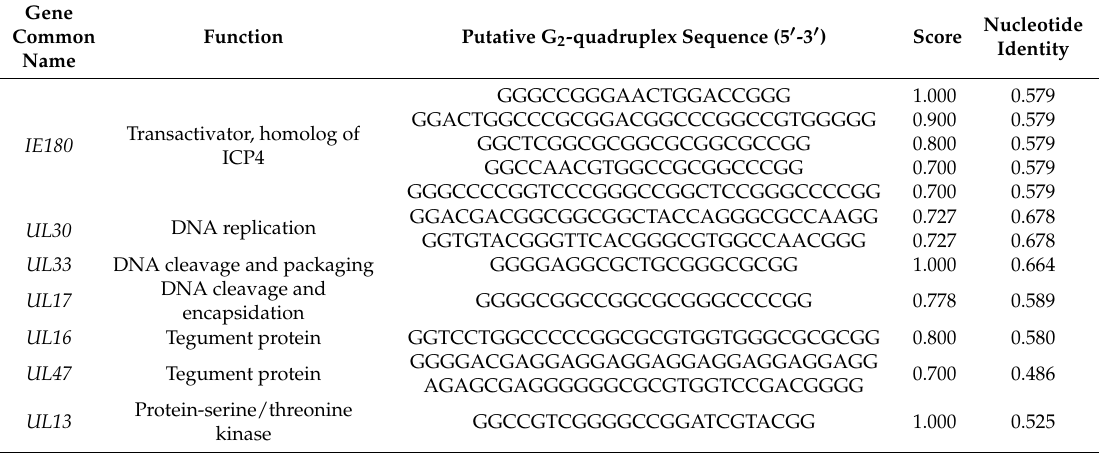
Table 2. G 2 -PQS with high conservation score in the coding sequence of Varicellovirus genes. Gene